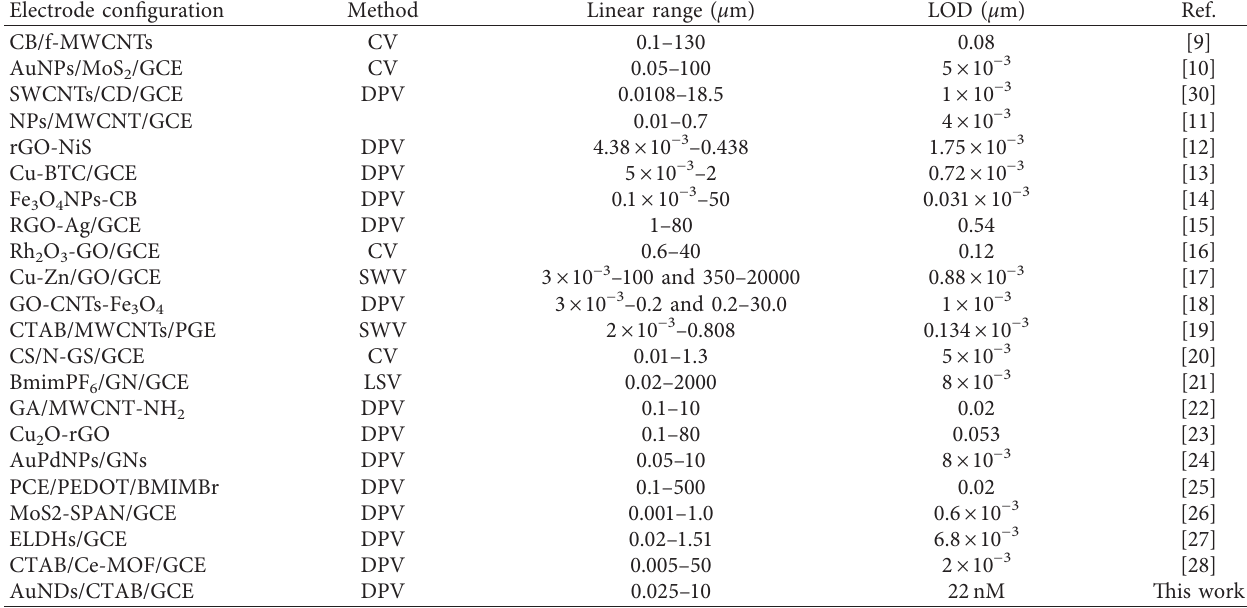
Table 1: Comparison of sensing performances of electrochemical sensors for detection of BPA.